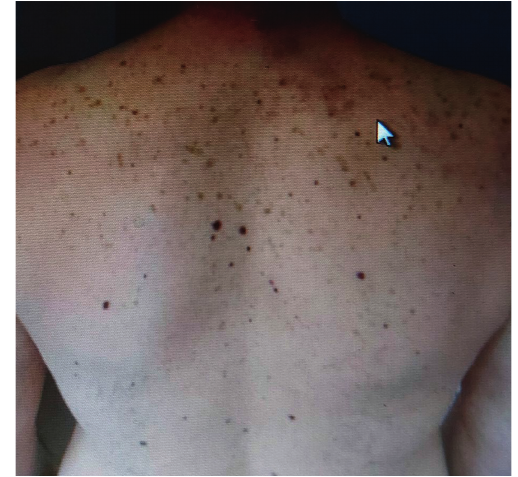
Figure 3: Resolved skin lesions of herpes